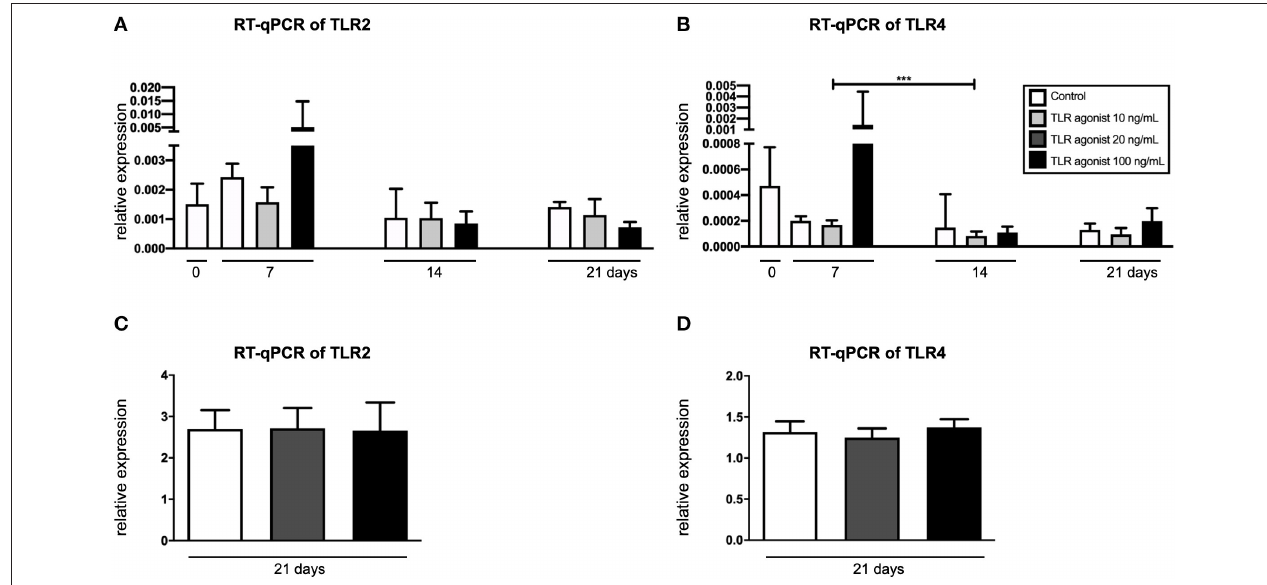
FIGURE 5 | GFs and monocytes express TLR2 and TLR4. (A) Expression of TLR2 and (B) TLR4 in GFs cultures ( t = 0) and co-cultures of GFs and PBMCs ( t = 7, 14, and 21). (C) Expression of TLR2 and (D) TLR4 in cultures of CD14 + cells, cultured with M-CSF and RANKL. LPS-PG (Invivogen, San Diego, CA, USA) was used as TLR2 and TLR4 agonist in concentrations of 10ng/mL or 20ng/mL and 100ng/mL. n = 6 for the co-cultures and n = 4 for the CD14 + cells’ culture; average results ± SD are shown. Significant results are shown (black bars). *** p <